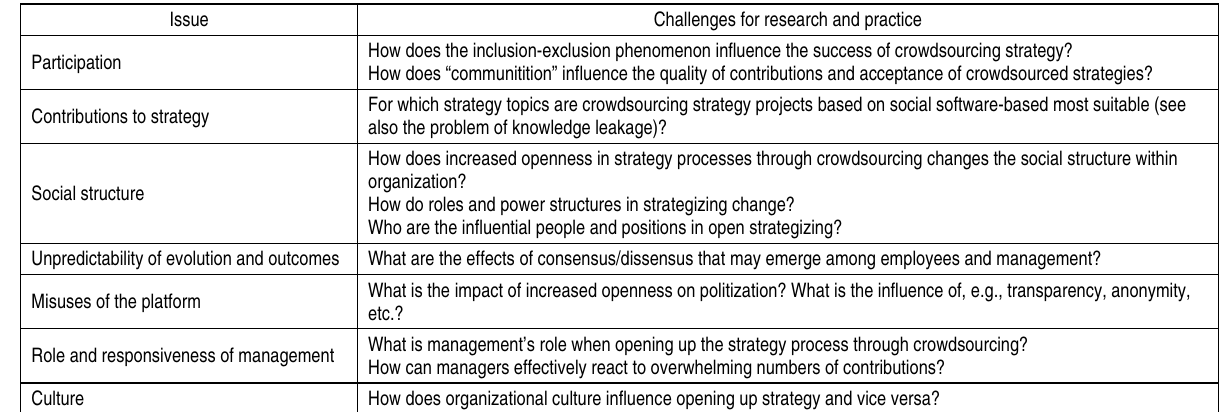
Table 2. Identified issues and